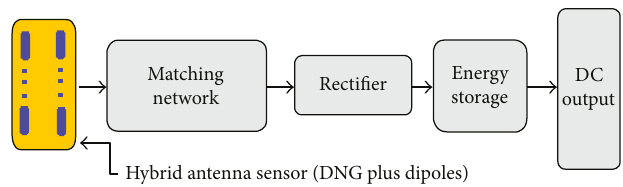
Figure 7: The scheme of an ordinary harvesting system with the hybrid antenna sensor (DNG plus dipoles).